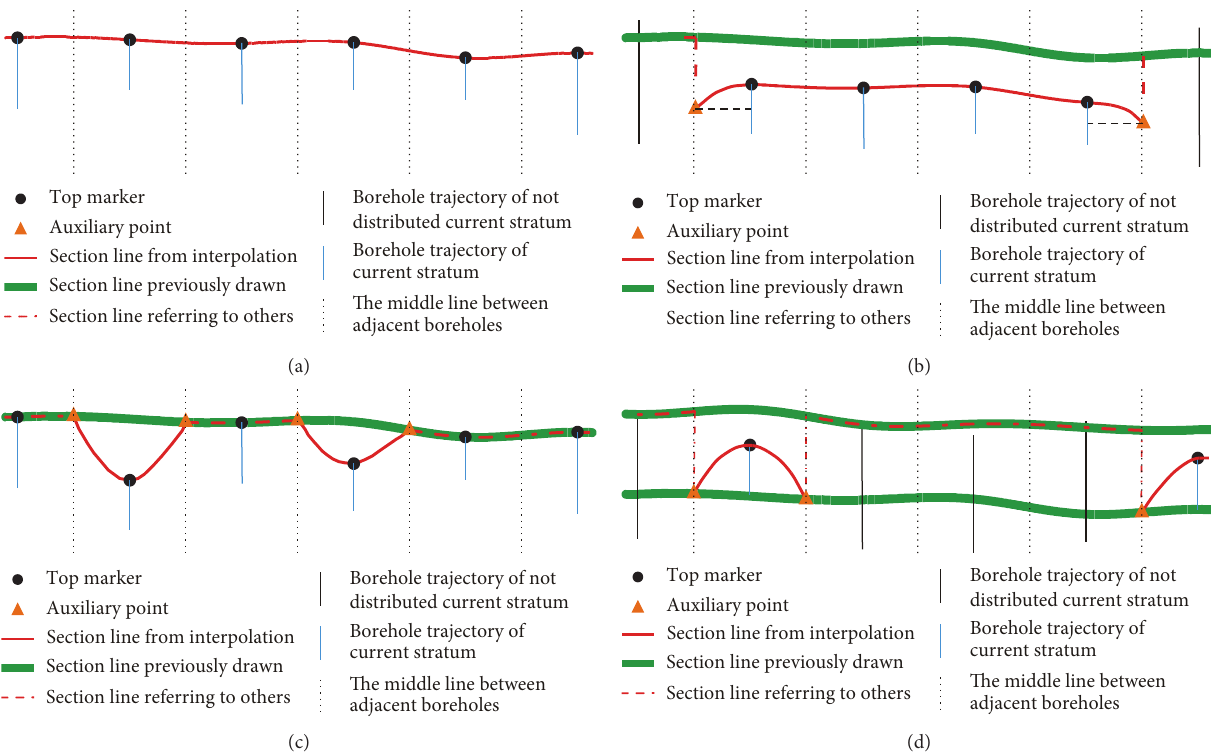
Figure 6: Diagram of automatically drawing the top boundary of the current stratum: (a) section line of direct interpolation, (b) section line from the reference section line and interpolation with the constraint of auxiliary border points, (c) section line from the referred section line and interpolation with the constraint of auxiliary reference top points, and (d) section line from the referred section line and interpolation with the constraint of auxiliary reference base